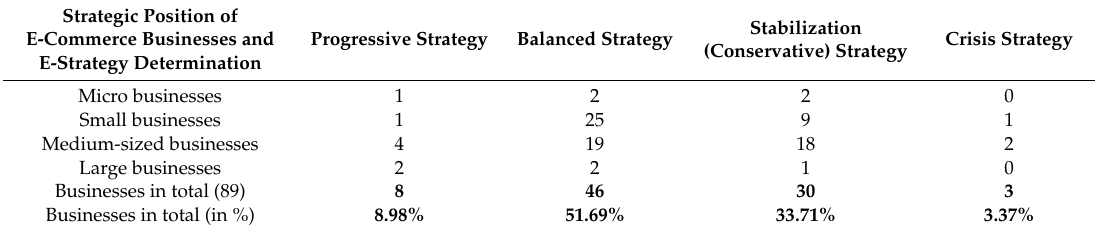
Table 2. Strategic position of e-commerce businesses and e-commerce strategy determination. Source: own research.